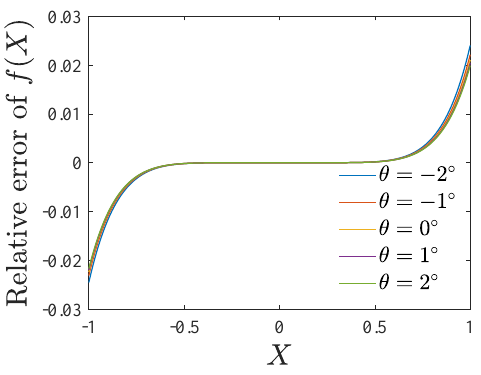
Figure 10. Relative error of Taylor expansion of f ( X )